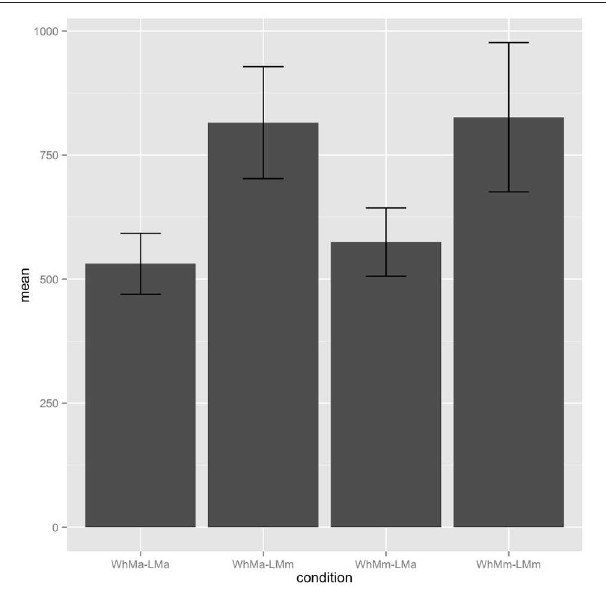
FIGURE 4 | Experiment 4 spillover region regression path